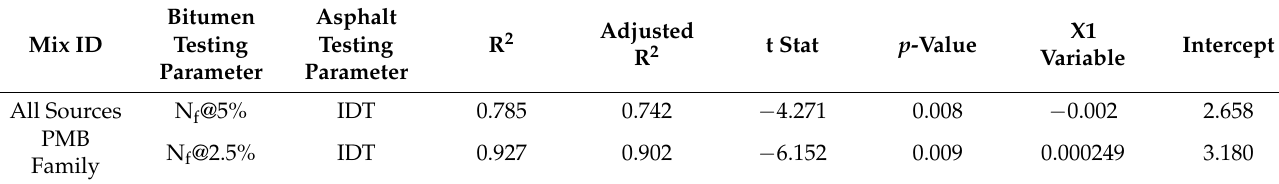
Table 8. Best correlated parameters and testing conditions between a LAS test@25 ◦ C on bitumen and IDT@25 ◦ C on asphalt